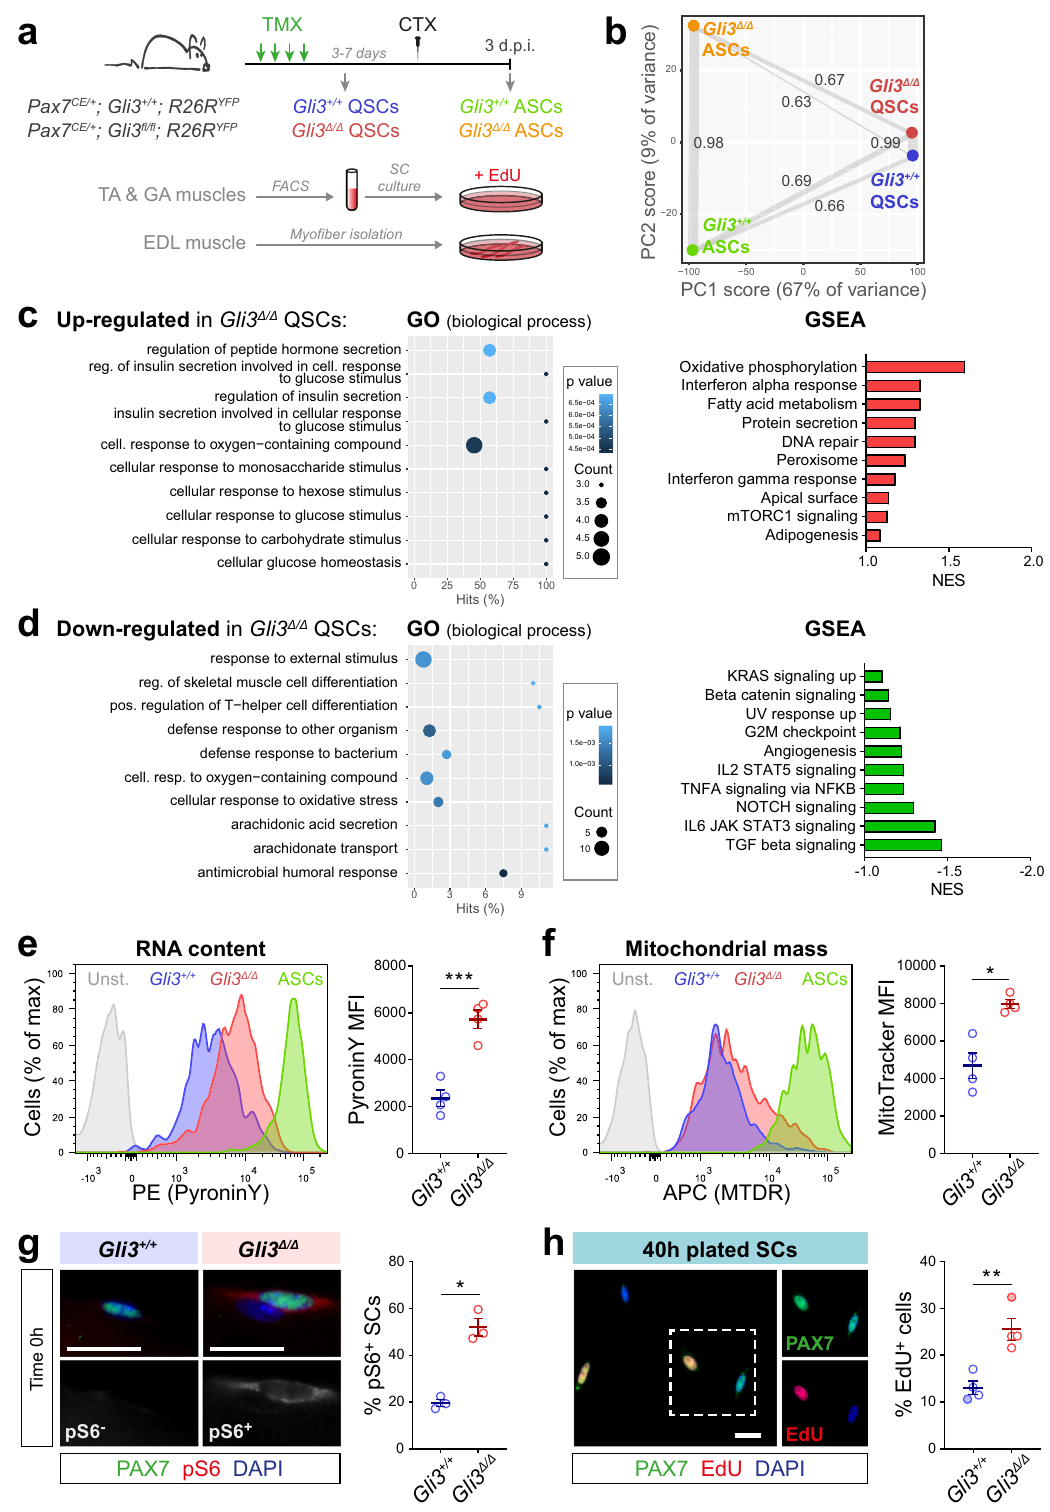
their enhanced ability to self-renew and regenerate. As well, GO analysis and GSEA on the 629 downregulated genes highlighted biological process terms mainly related to cell adhesion, apical junction/surface, and epithelial-mesenchymal transition (Fig. 6b), supporting the idea that Gli3 Δ / Δ ASCs are less adhesive to their environment during regeneration, allowing more ef fi cient migration and muscle tissue repair 2,37 . NATURE COMMUNICATIONS| (2022) 13:3961